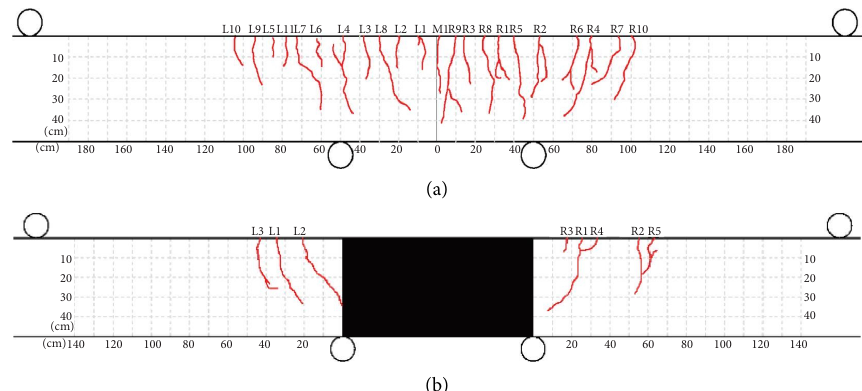
Figure 6: Actual distribution sketch of cracks in CPCSP and UPCSP. (a) 5A. (b) 5-1.